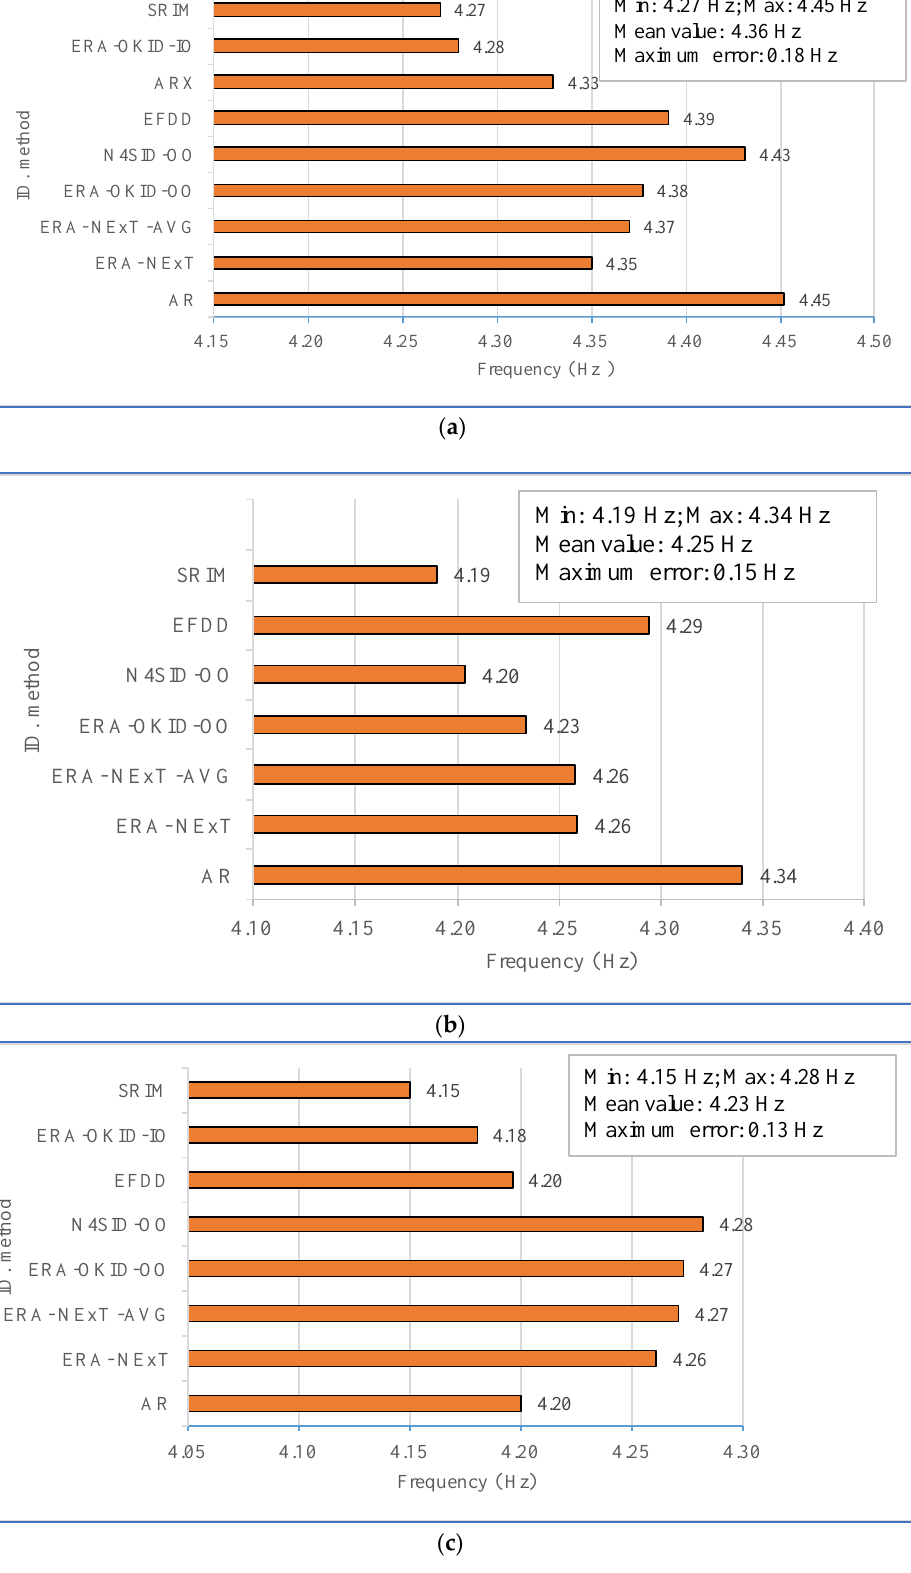
Figure 8. Mode 2 frequency obtained by the different identification methods: ( a ) 2001 San Fernando earthquake; ( b ) 2008 Chino Hills earthquake; ( c ) 2011 Newhall earthquake 2011. Table 6. Record of observation channels 9, 12, and 15 of the dam foundation following the river as a uniform input; record of observation channels 1, 2, 5, 6, 7, and 8 of the dam body following the river as the output; and the system identification results of frequency and damping.